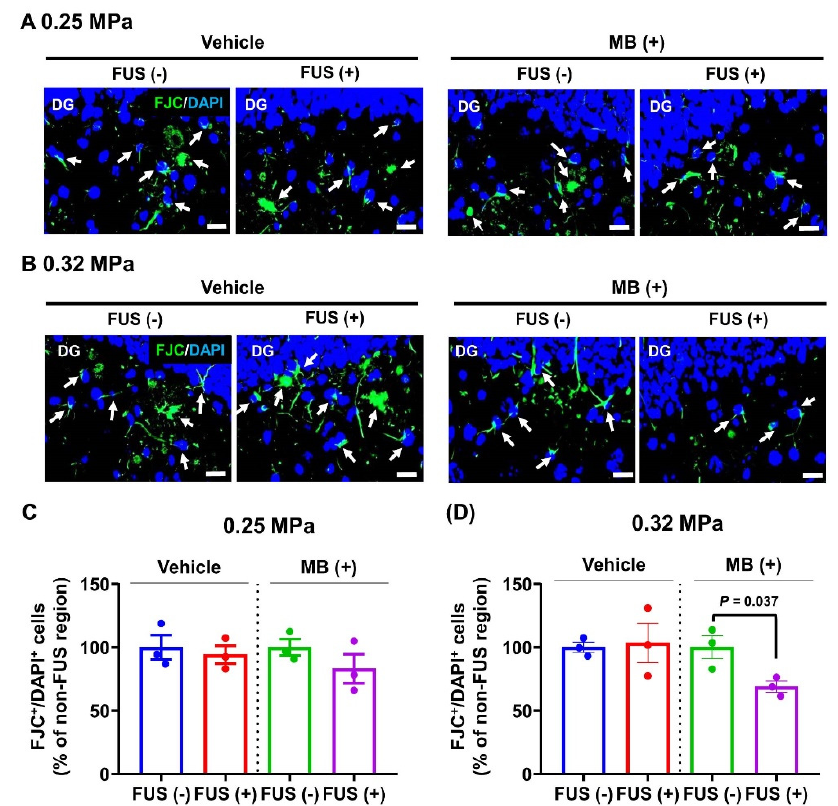
Figure 6. Evaluation of neural cell damage in FUS-treated and FUS/MB-treated APP/PS1 mice. ( A , B ) Representative photomicrographs of FJC (damaged neural cell marker) staining (green) cap- tured from the DG of the hippocampal region of animals in the 0.25 MPa ( A ) and 0.32 MPa ( B ) groups. The number of FJC-positive cells in the cortex and hippocampal regions in accordance with the FUS target (ROI = 5.1 mm 2 in each hemisphere) was determined. White arrows indicate double-positive cells for FJC and DAPI (a nucleus marker) (green). ( C , D ) The number of FJC/DAPI-double-positive cells in the cortex and hippocampal regions of animals in the 0.25 MPa ( C ) and 0.32 MPa ( D ) groups was determined. Data in the bar graph are presented as mean ± SEM (N = 3). Statistical significance was analyzed using two-tailed unpaired t -test. Scale bars represent 20 µ m in ( A , B